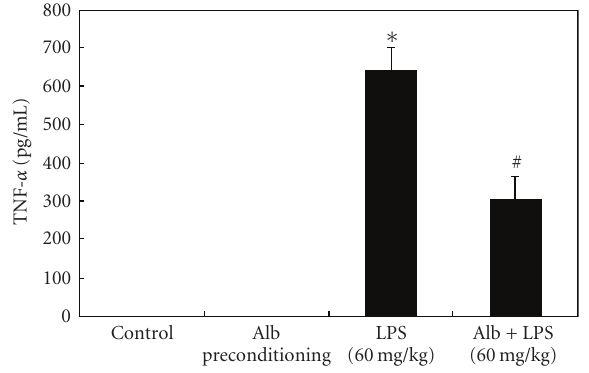
Figure 5: Albumin preconditioning abrogates LPS-mediated TNF- α expression in vivo . C57Bl/6 mice, 20–25g body wt, were preconditioned with BSA (10mg/kg body wt, i.p.) or vehicle 18h prior to subsequent treatment with a lethal dose of LPS (60mg/kg body wt, i.p.). Plasma was harvested at 6h, and TNF- α was measured via ELISA. Albumin preconditioning significantly inhibited LPS-mediated plasma TNF- α expression. Experiments were performed in triplicate with 5mice per experimental group ( ∗ P < . 05 compared to control; # P < . 05 compared to LPS